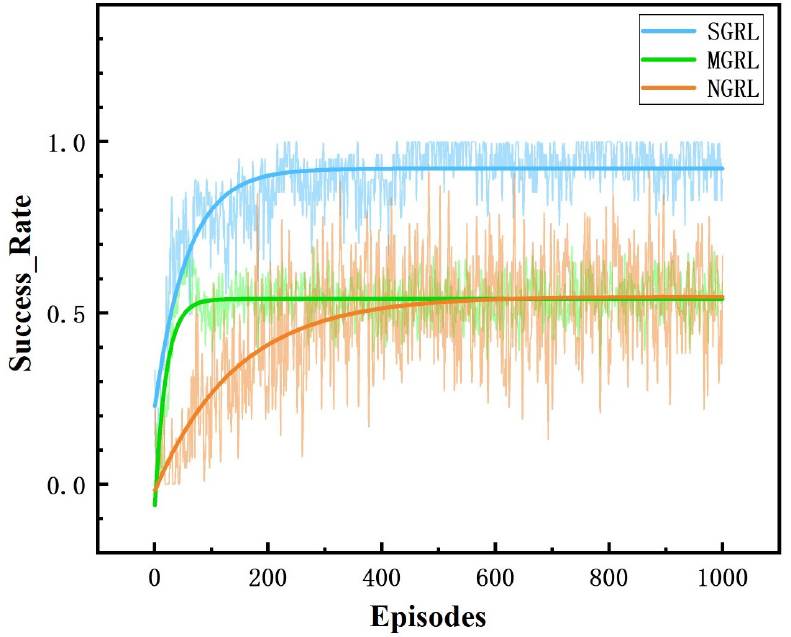
Figure 14. Diagram of success rate. This value is obtained by the ratio of the number of vehicles completing the task (entering the corresponding ramp) to the total